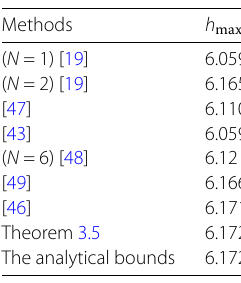
Table 3 Upper bound on h obtained for Example 4.3